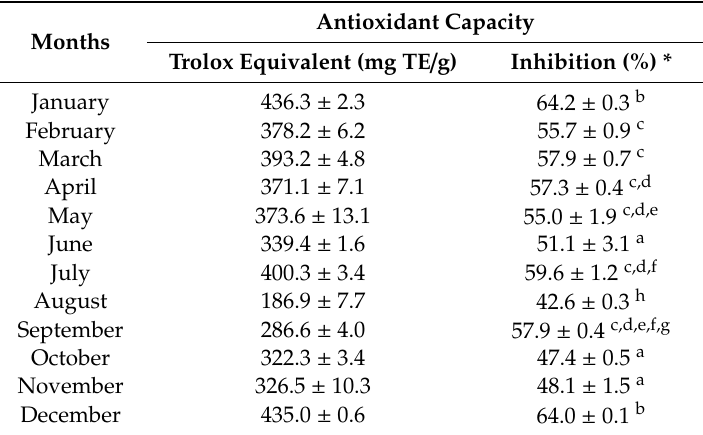
Table 2. Antioxidant capacity of the monthly oils of Eugenia uniflora